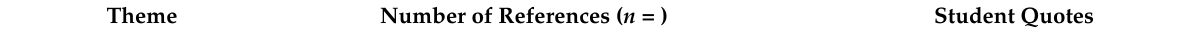
Table 1. The types of benefits that pharmacy students experienced during initial COVID-19 changes.